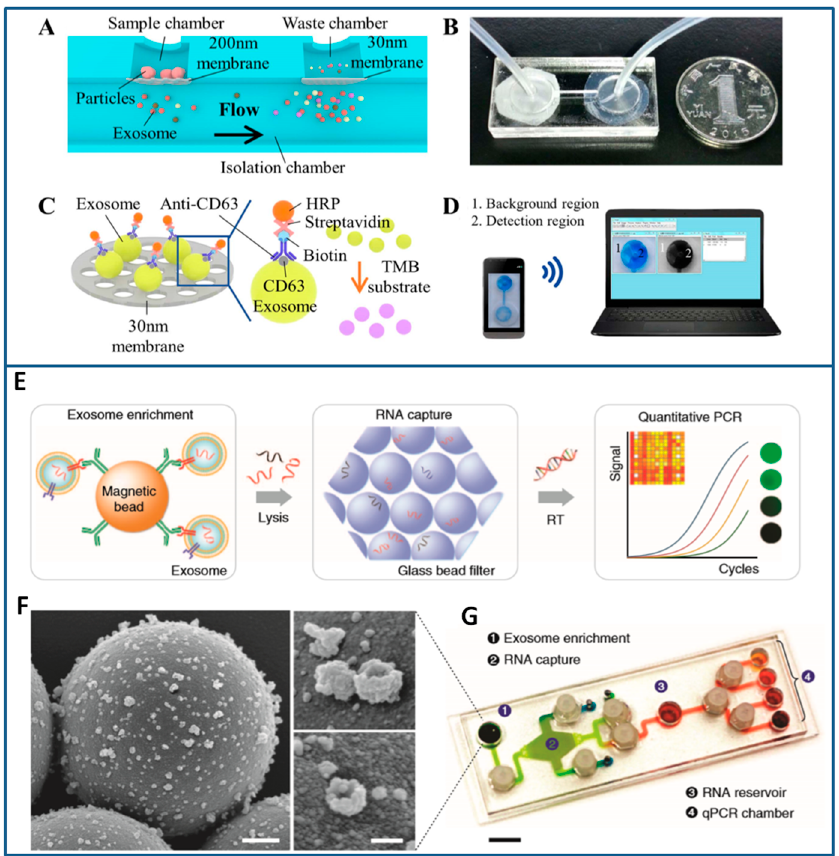
Figure 13. ( A ) Microfluidic platform including a double-filtration module for the size-exclusion for the isolation, enrichment and quantification of exosomes in the isolation chamber ( B ) from urine samples of patients with bladder cancer. Reproduced with permission from reference [143]. The platform allows the labelling of exosomes for an on-chip ELISA and the spots are imaged using a cell phone ( C , D ). Another example is the iMER platform that integrates a site for exosomes enrichment through magnetic beads ( E ), a lysis module, a RNA capture module with charged glass beads ( F ) and a qPCR amplification chamber ( G ). Figure reproduced with permission from reference [171].